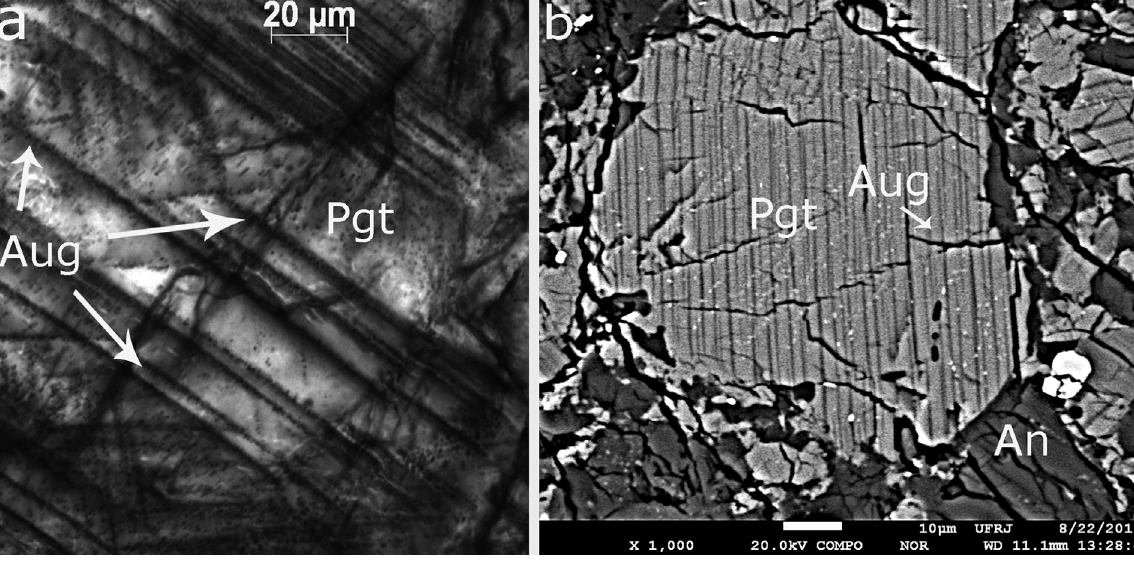
Figure 5 - Pyroxene of Serra Pelada showing pigeonite and augite exsolution lamellae as dark lines. a ) Transmitted plane polarized light photomicrograph b ) back scattered electron (BSE) image. Pgt: pigeonite; Aug: augite; An: